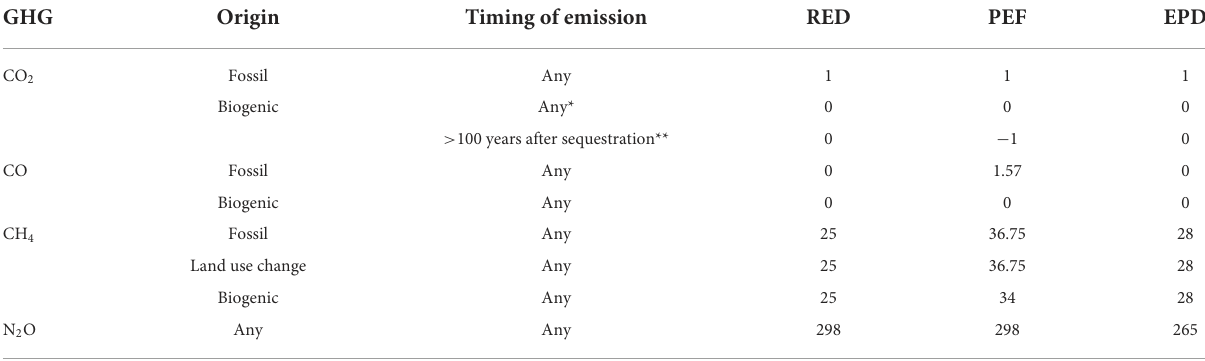
TABLE 2 GHG characterization factors in RED (EC, 2018a, p. 152), PEF (EC, 2018b, p. 70), and EPD (2019). GHG Origin Fossil Biogenic